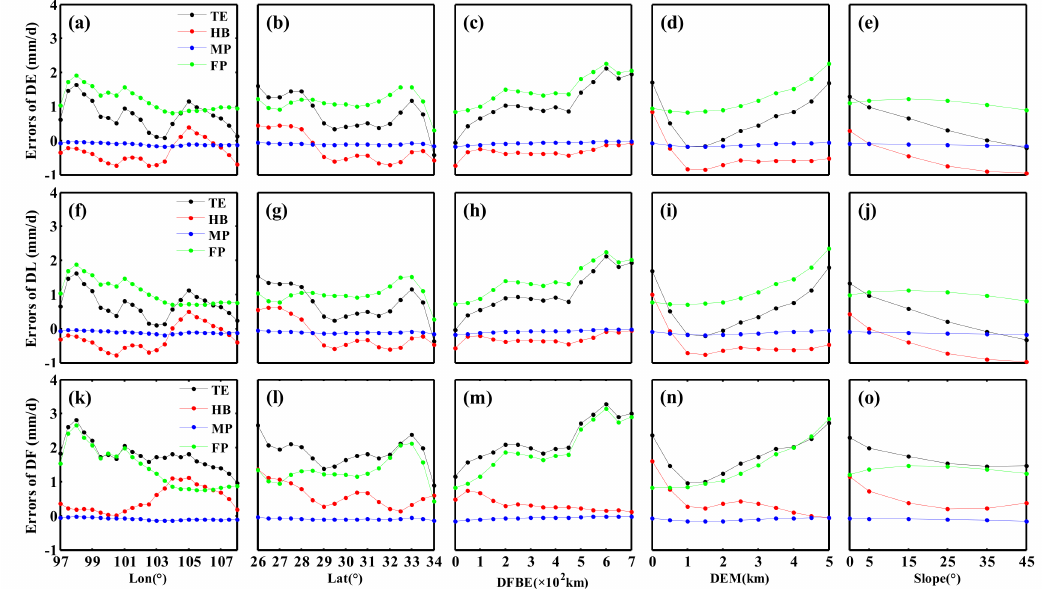
Figure 8. The distribution of total errors and three independent components with five geographical features for the IMERG-DE, DL, and DF estimates. From left to right, five columns represent longitude ( a , f , k ), latitude ( b , g , l ), DFBE ( c , h , m ), DEM ( d , i , n ), and slope ( e , j , o ), respectively. From top to bottom, three rows represent errors of IMERG-DE ( a – e ), DL ( f – j ), and DF ( k – o ),